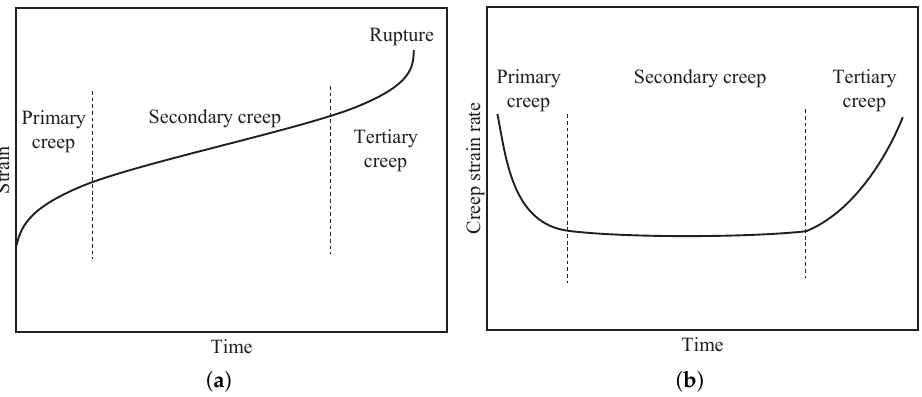
Figure 1. Creep response of typical PBMs. ( a ) The complete creep process curve, and ( b ) the creep strain rate vs. time